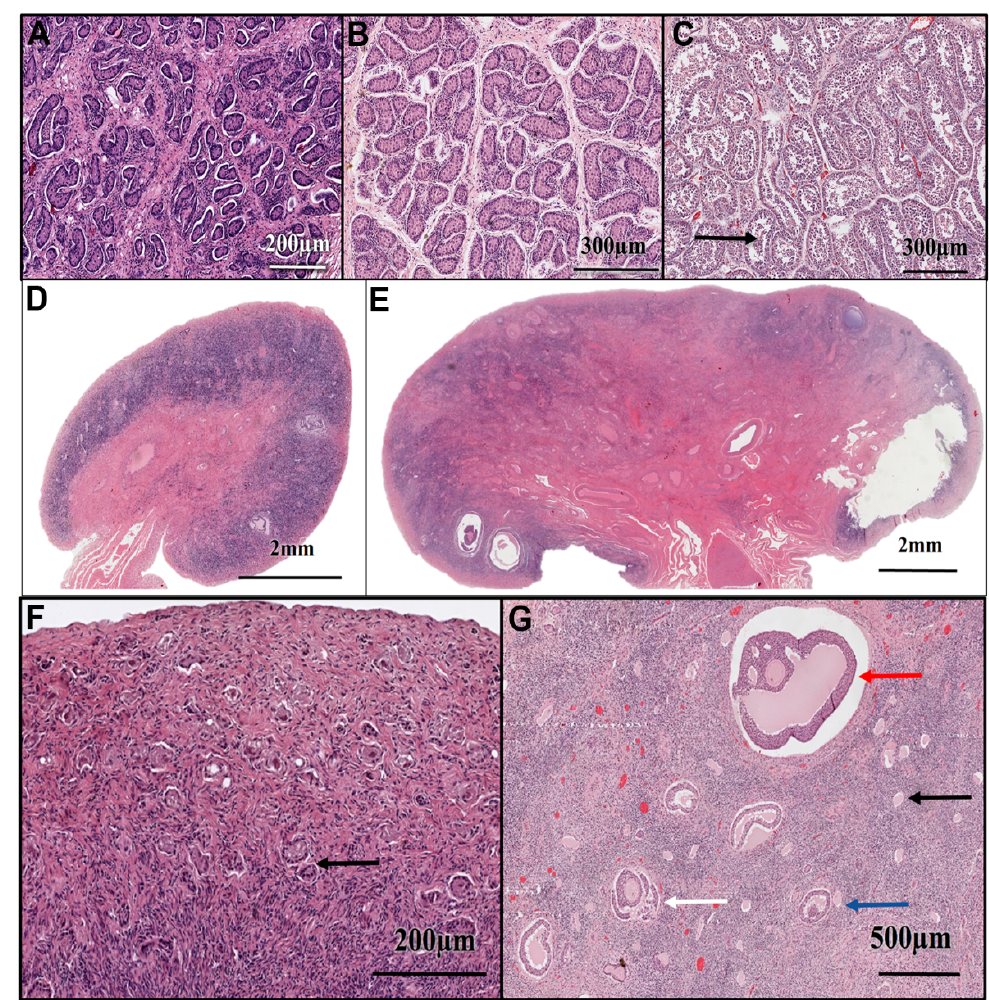
Figure 2. S. coeruleoalba age estimation according to body length and pectoral flippers bone charac- ters. ( A ) X-ray radiography of the epiphysis of radius, ulna, and metacarpals of pectoral flippers was used for age evaluation (insert, red square insert). Arrows point to the radioulnar epiphysis epithelium without spermatozoa were immature (Figure 3A,B), while those with spermato- used for age evaluation. ( a ) radio-ulna epiphyses radiolucent at stage 3 of pre-weaned female (CR05- zoa were mature (Figure 3C). When female dolphins reach maturity, ovaries present diverse 20), of ~2.5 years old; ( b ) trabecular bridge visible of a juvenile female (CR01-18) epiphyses at stage structures and follicles, in which the cortex is rich in primordial follicles, and no other 4 of ~ 7 years old; ( c ) ghost physis present in a female, young adult (CR05-19) at stage 5 of ~11.5 structures are apparent (Figure 3). Regarding the females, 6/23 were immature, with ages years old; and ( d ) adult male (CR10-20) at stage 6 of > 25 years old years, where remodeling of the lower than five years, and 17/23 were mature (5 ≥ 166 cm and <189 cm). The panorama in physical region and replacement of the physeal line by mature bone tissue occurs. ( B ) Correlation between FBSA and body length. ( C ) Correlation between FBF (x = 0.000383y 3 − 0.0019398y 2 + males was the opposite: 20/28 were immature, and 8/28 were mature ( ≥ 191 cm). Again, 0.1101071y − 0.2517343) and body length. The dotted curves denote three dolphin age models ac- inconsistencies between sexually mature males and females related to GLGs, FBSA, and cording to Stenella dolphins’ body length [3,6,53,54]. R 2 denotes the proportion of variation of age FBF were evident (Figures 1 and 2). Overall, dolphins of ≥ 190 cm were mature (17/18 for estimation according to flippers’ bone characters with body length. (Details in Supplemental Data GLG, 12/14 for FBSA, and 13/14 for FBF), while smaller dolphins (<189 cm) were mainly S1). The formulas for the slope of the curves are depicted in Figure 1. sexually immature (13/16 for GLGs, 11/16 for FBSA, and 14/19 for FBF).